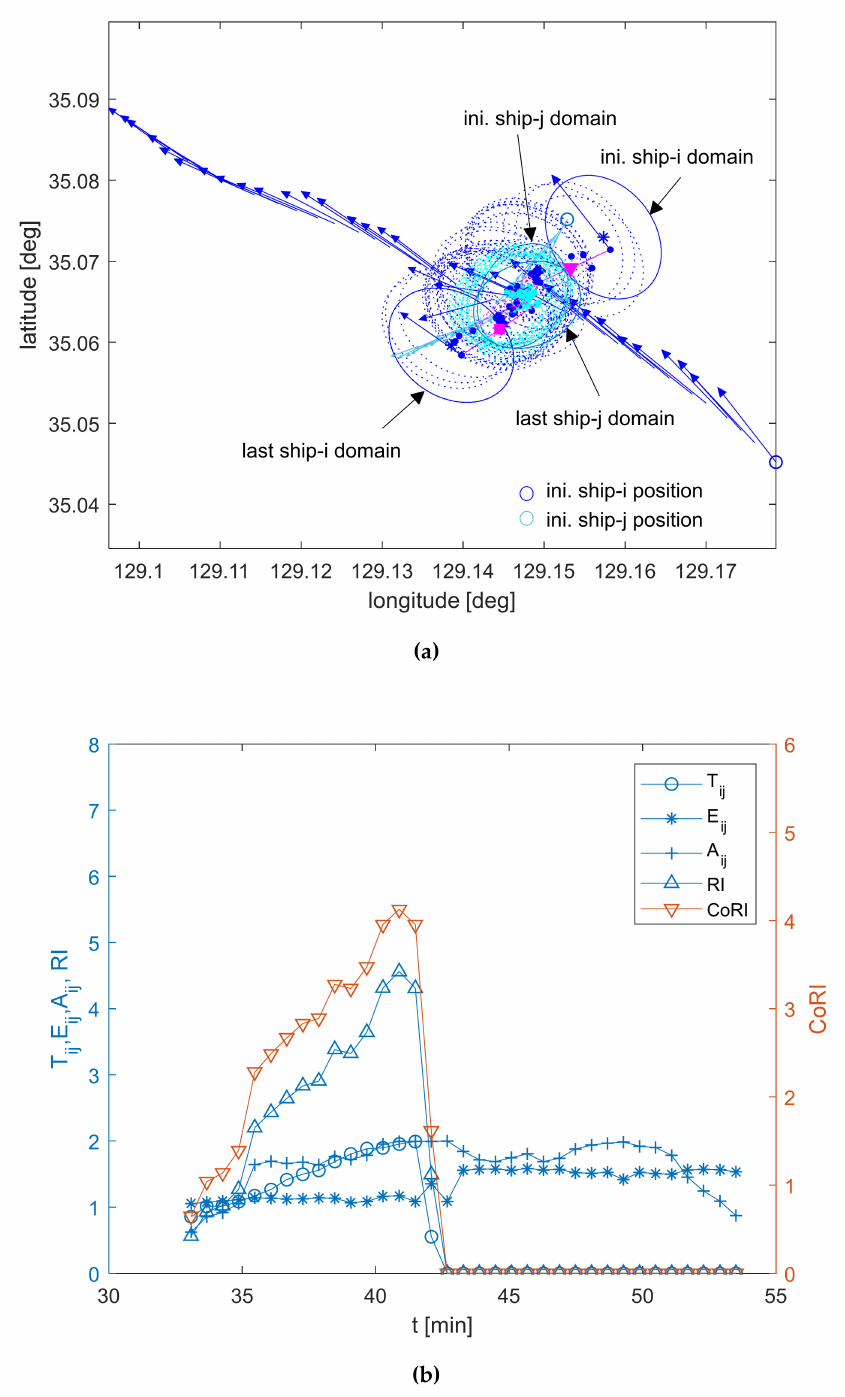
Figure 6. ( a ) Ship tracks with VTSO ship domain at CPA position ( · : CPA position, ← : 3-min vector); ( b ) CoRI results with T, E, and A indices of scenario no.6 ( ship-i : ship-2, ship-j :